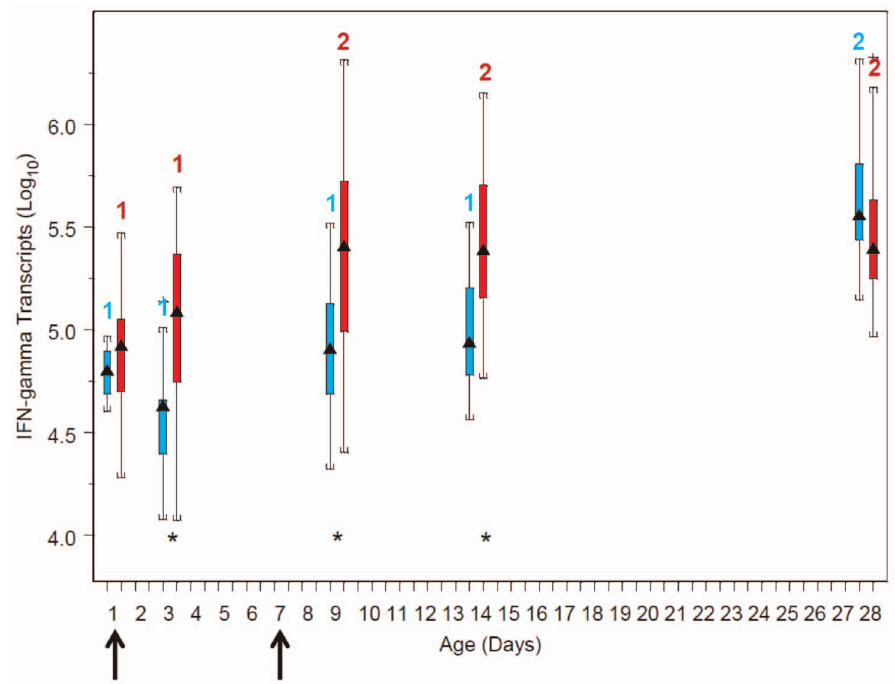
Figure 1. Boxplots of log 10 values of mRNA copy numbers by age and treatment group: blue boxes are data from the control (saline) group and red boxes are data from the CpG-treated foals. The triangles in the middle of boxes represent the median value; the bottom and top of the boxes represent the 25 th and 75 th percentiles, respectively. The vertical lines extending from the boxes to horizontal lines represent multiples of 1.75 of the respective interquartile distance. Numbers above boxes represent within-treatment group differences among ages: within treatment group, ages with different numbers differed significantly (P , 0.05) between groups. Asterisks denote days on which values were significantly (P , 0.05) different between the control and Cp-G-treated foals. Arrows along the horizontal axis indicate ages when treatment (saline or CpG) was administered.